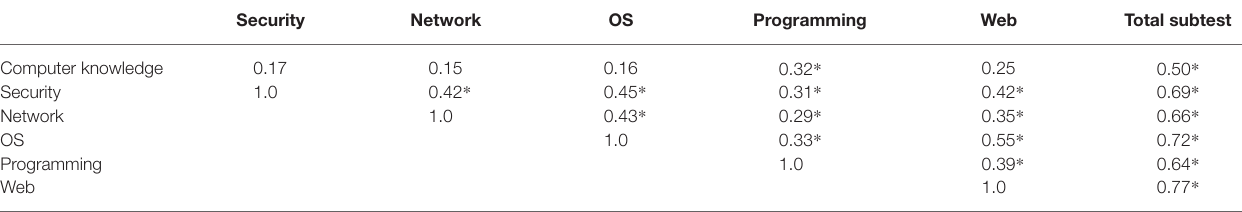
TABLE 2 | Correlation between scores on different parts of the knowledge subtest, and between parts and total subtest score. Security